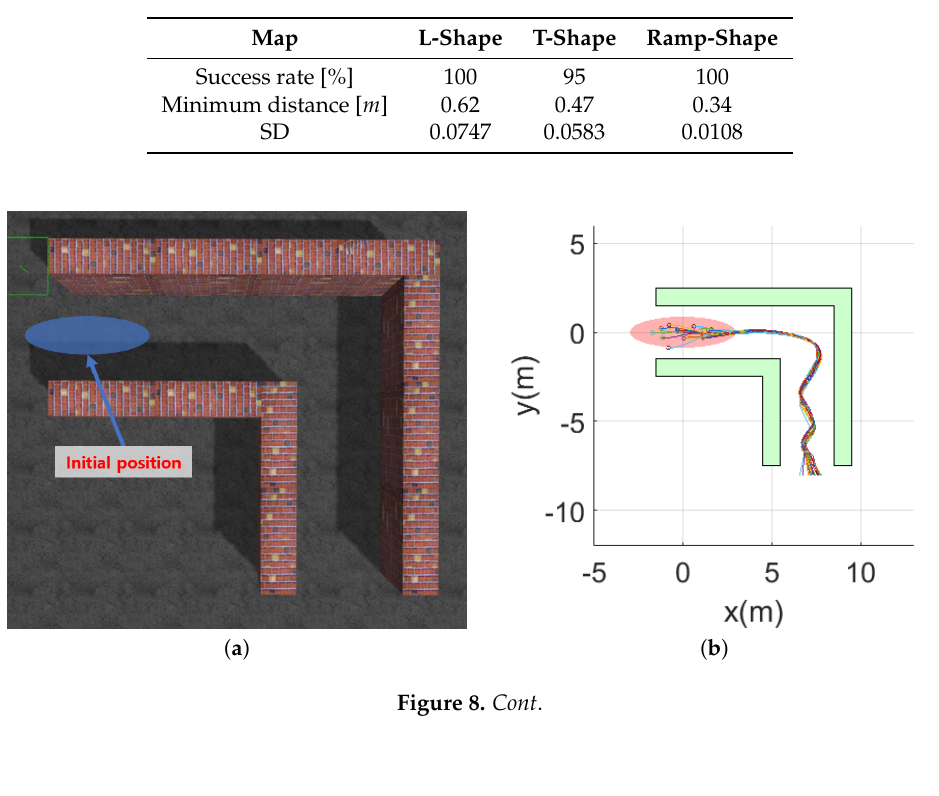
Table 1. Simulation results of obstacle avoidance for three types of map (SD, standard deviation of minimum distance with 20